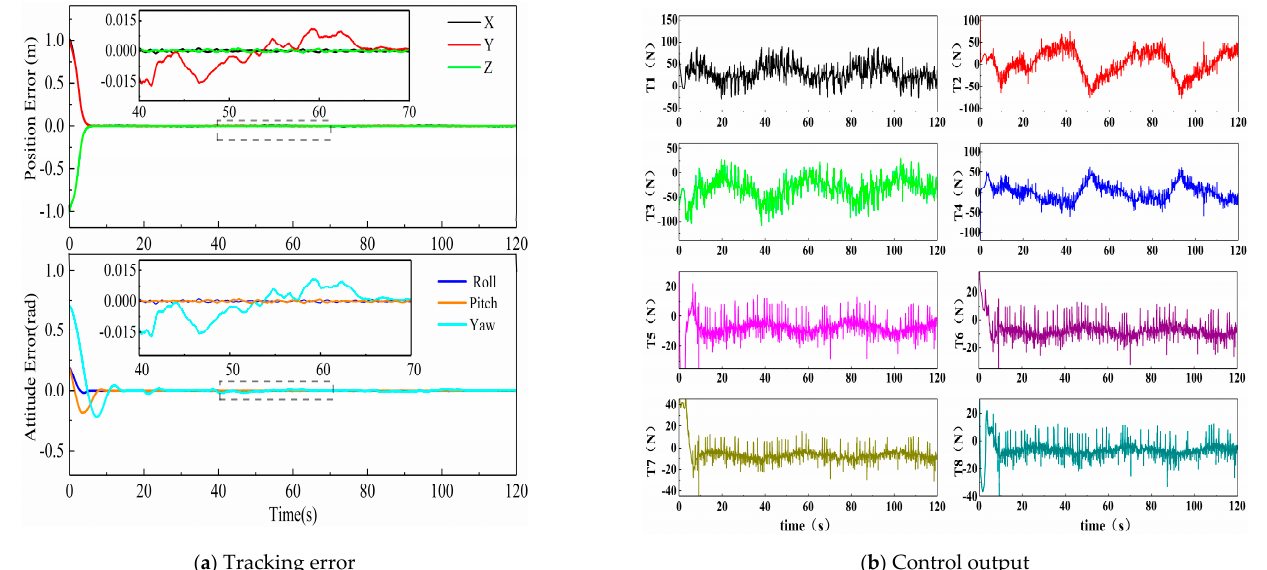
Figure 5. The control effect of FTESO − FTC under Case 2.